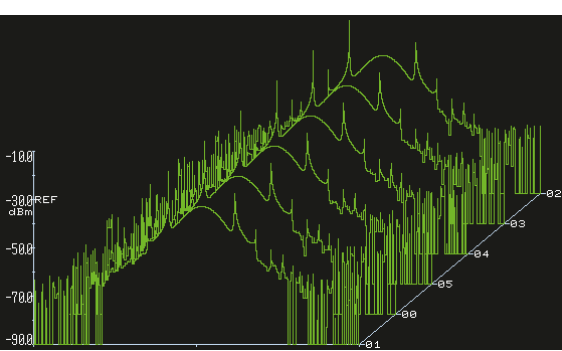
Figure 5: Long-term stability of optical